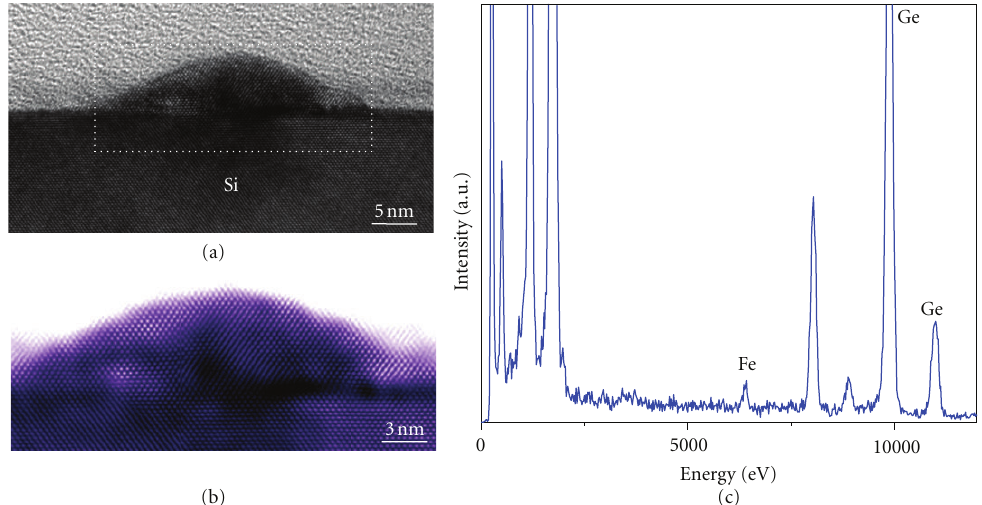
Figure 13: (a) A high-resolution TEM image of one Fe 0 . 02 Ge 0 . 98 QD on Si. (b) A magnified Fourier-filtered image of the marked area in (a), showing nearly perfect lattice coherence between Si and QDs. (c) EDX results for Fe concentration ( ∼ 2 atom%). Reproduced from [18]. Copyright ©2010, American Chemical